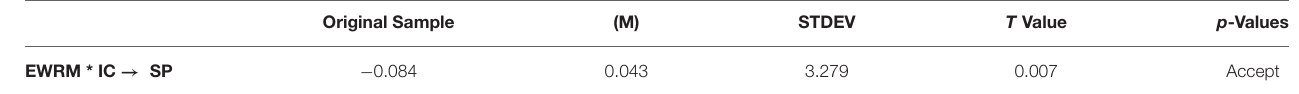
TABLE 6 | Moderating hypothesis